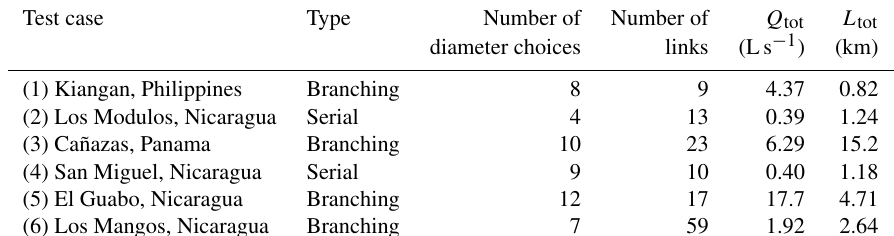
Table 1. Characteristics of test cases.